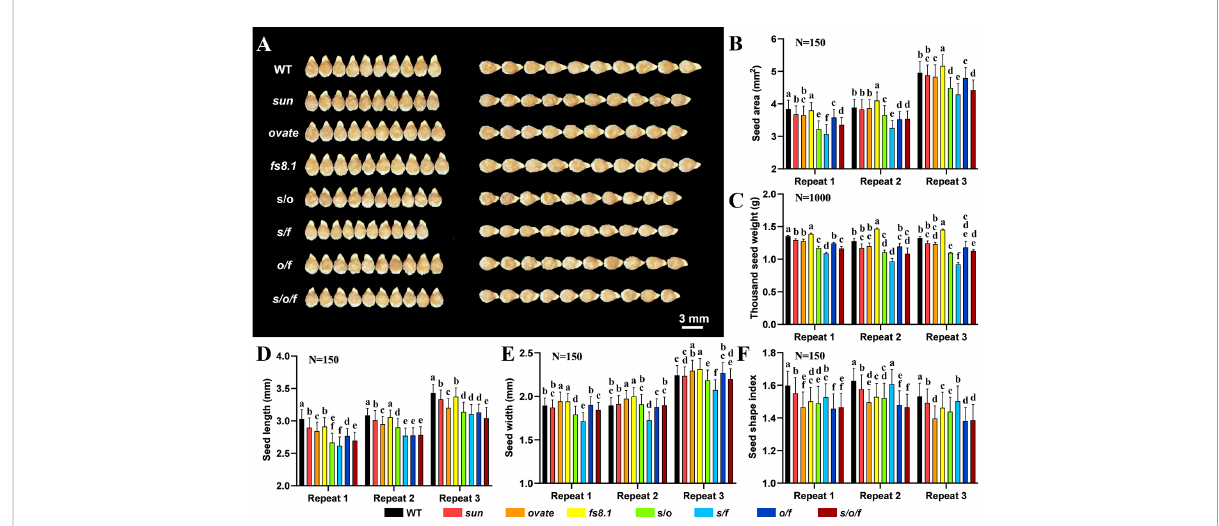
FIGURE 2 Seed size and shape variations of fruit shape NILs. (A) Mature seeds. (B) Seed area. (C) Thousand seed weight. (D) Seed length. (E) Seed width. (F) Seed shape index. “ N ” stands for the number of seeds that was analyzed for each genotype in each replication. Pairwise comparisons between the NILs were done with ANOVA and means were separated with Turkey ’ s test a < 0.05. Small alphabet letters above the bars indicate the signi fi cance of the HSD